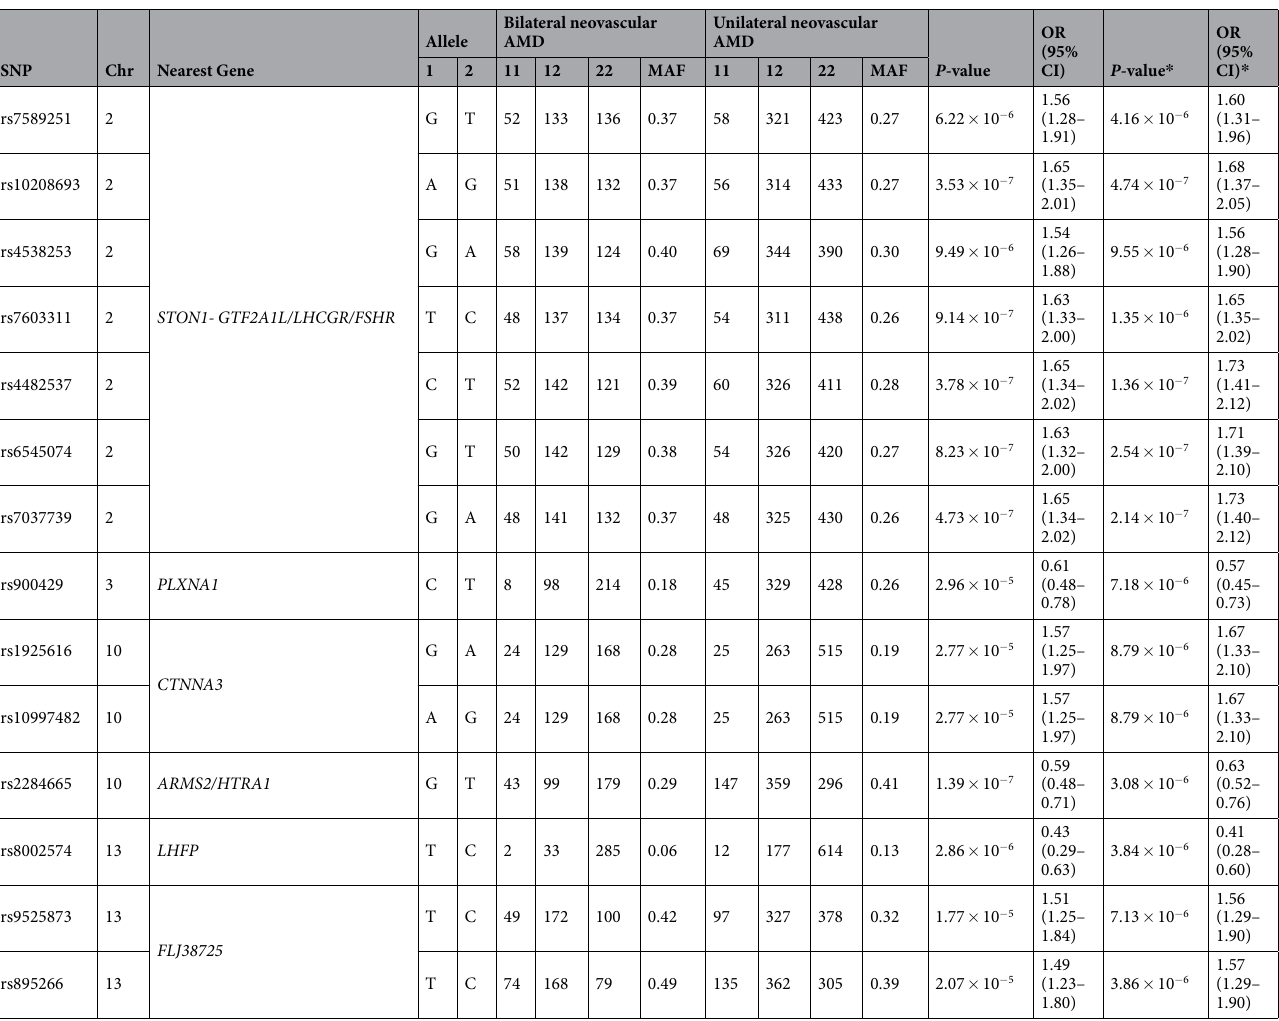
Table 2. Results of discovery study for the 14 SNPs that showed P -value < 10 − 5 , comparing bilateral neovascular age-related macular degeneration cases with unilateral those. SNP, single nucleotide polymorphism; Chr, chromosome; MAF, minor allele frequency; OR, odds ratio; CI, confidence interval. * Adjusted for age and